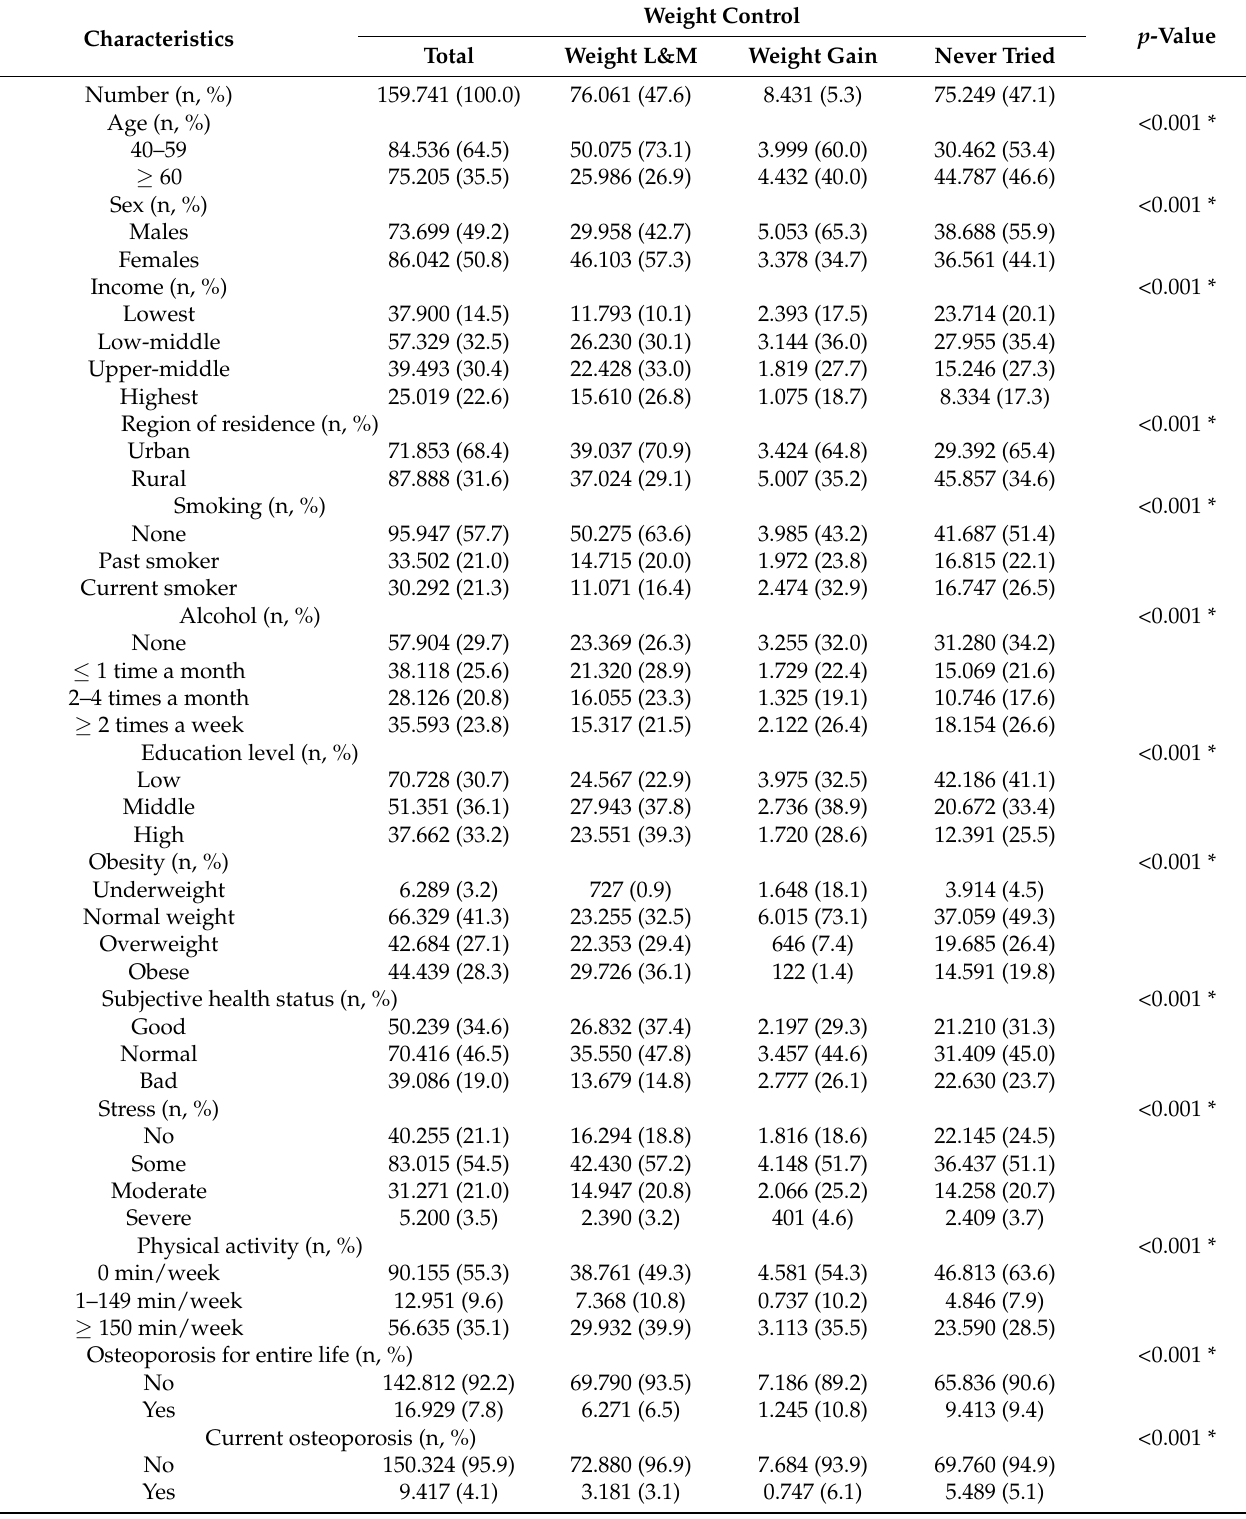
Table 1. General characteristics of the